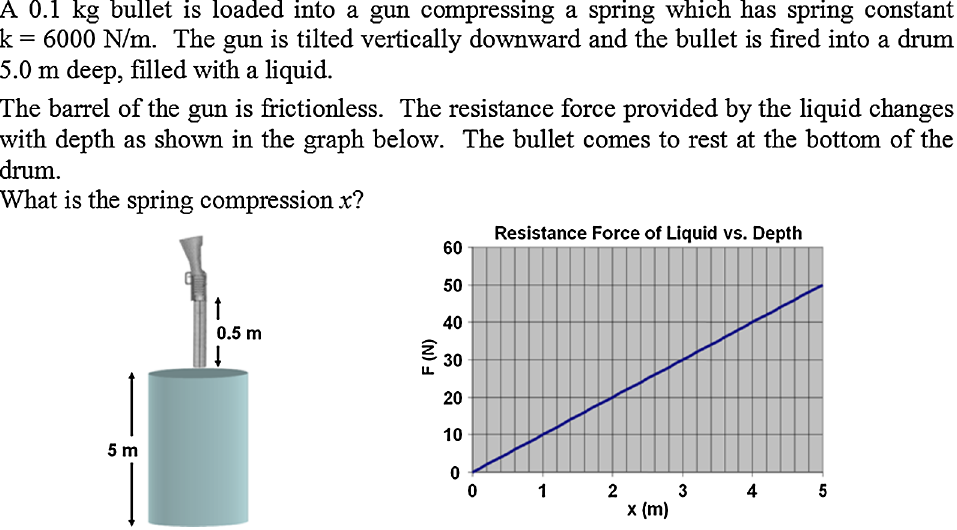
FIG. 2 (color online). The barrel problem (interview